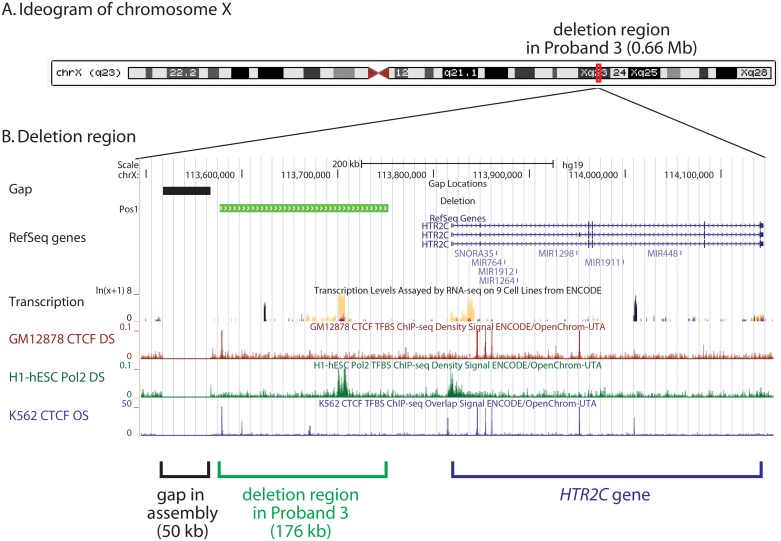
Hemizygous deletion in proband 3 spanning 176 kb in a regulatory region of the gene encoding an X-linked serotonin receptor, HTR2C.(A) An ideogram of chromosome X from the UCSC Genome Browser is shown, indicating the deletion site on Xq23. (B) The deletion region and surrounding landscape is shown, spanning 660,000 base pairs (chrX:113,495,001–114,155,000). The deletion region spans 106 SNPs (GRCh37/hg19 chrX:113,577,005–113,752,952). A 50 kb gap at the 3’ end of the deletion is indicated (chrX:113517669–113567668). Upstream regulatory elements are indicated displayed on tracks for transcription level from RNA-seq and transcription factor ChIP-seq.